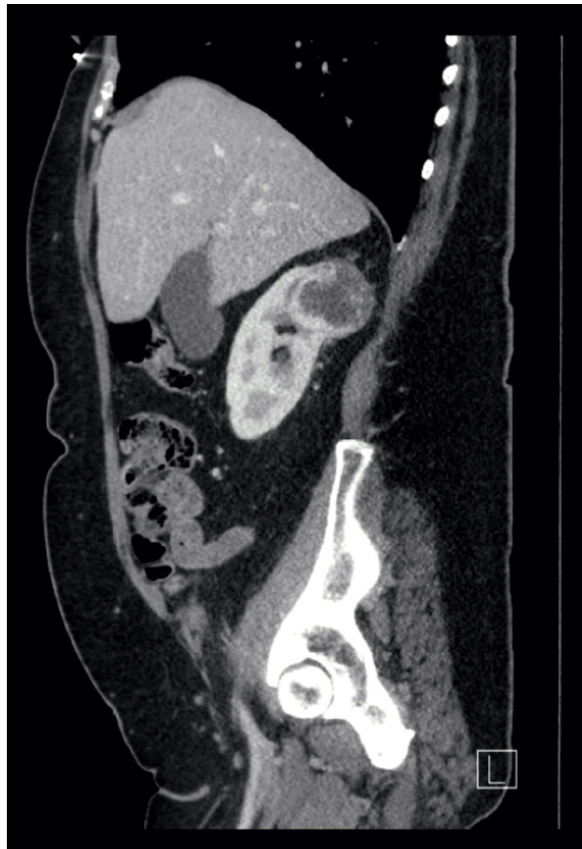
Figure 2: Sagittal CT view showing upper pole right renal tumour.